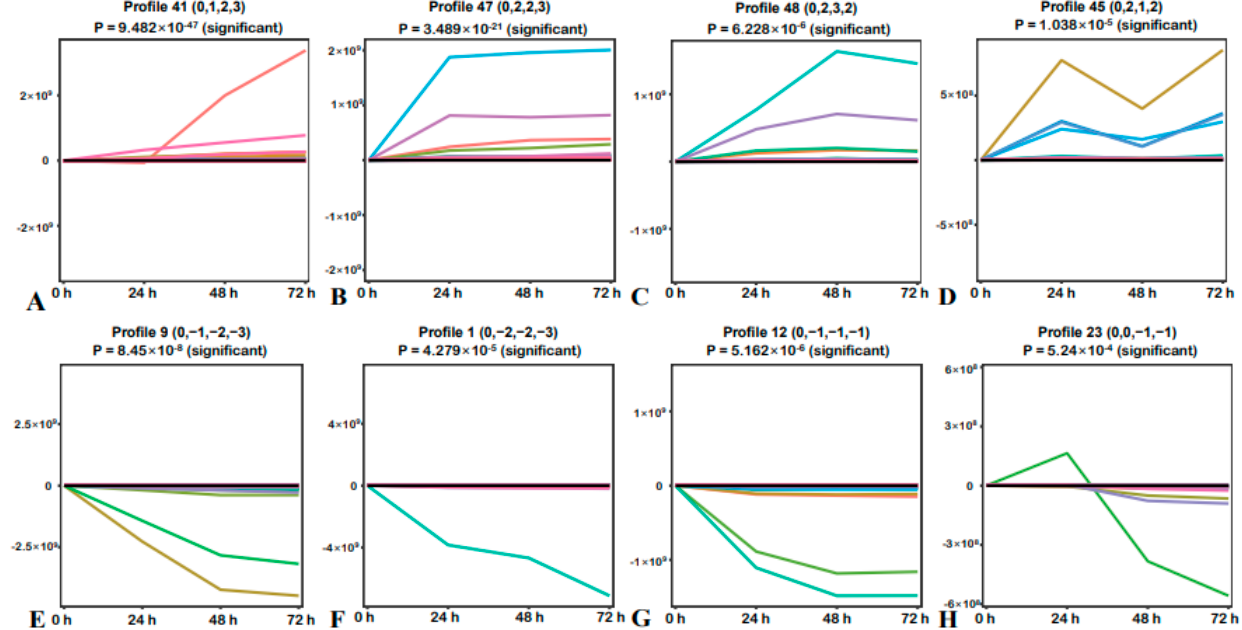
Figure 2. Analysis of the changing trend in metabolites. The horizontal axis represents the salt treatment time (0, 24, 48, and 72 h). ( A ) Changing trend was 0.0, 1.0, 2.0, and 3.0, with a total of 110 differentially expressed genes (DEGs; 10.01%). ( B ) Changing trend was 0.0, 2.0, 2.0, and 3.0, with a total of 72 DEGs (6.55%). ( C ) Changing trend was 0.0, 2.0, 3.0, and 2.0, with a total of 56 DEGs (5.10%). ( D ) Changing trend was 0.0, 2.0, 1.0, and 2.0, with a total of 39 DEGs (3.55%). ( E ) Changing trend was 0.0, − 1.0, − 2.0, and − 3.0, with a total of 47 DEGs (4.28%). ( F ) Changing trend was 0.0, − 2.0, − 2.0, and − 3.0, with a total of 42 DEGs (3.82%). ( G ) Changing trend was 0.0, − 1.0, − 1.0, and − 1.0, with a total of 60 DEGs (5.46%). ( H ) Changing trend was 0.0, 0.0, − 1.0, and − 1.0, with a total of 35 DEGs (3.18%).